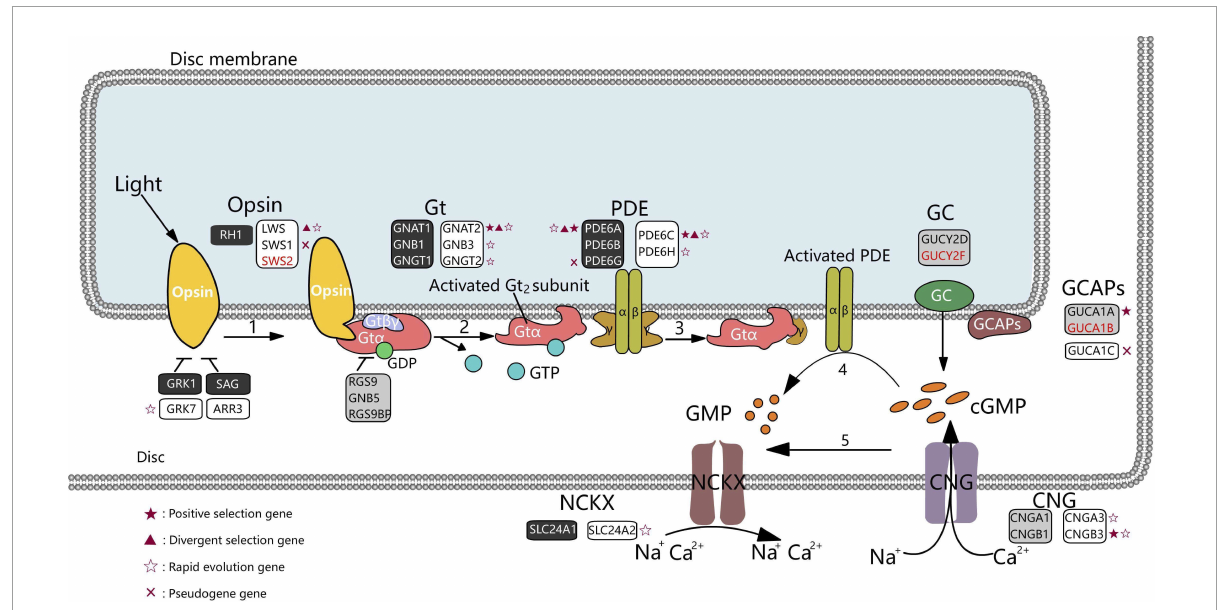
FIGURE1 Diagram of phototransduction pathway genes in marsupials. Rectangles represent genes involved in the phototransduction pathway (black, rods; white, cones; gray, rods, and cones). Genes in red font could not be identified in any marsupial. Red crosses represent pseudogenes in at least one marsupial species. Genes under positive selection (branch-site model), divergent, or rapidly evolving in the crepuscular genus Macropus are shown as red stars, red triangles, and hollow stars, respectively. Gt denotes G protein transducing; PDE, phosphodiesterase; GC, guanylate cyclase; GCAPs, guanylate cyclase-activating proteins; CNG, cyclic nucleotide-gated ion channels; NCKX, Na + /Ca 2 + -K +